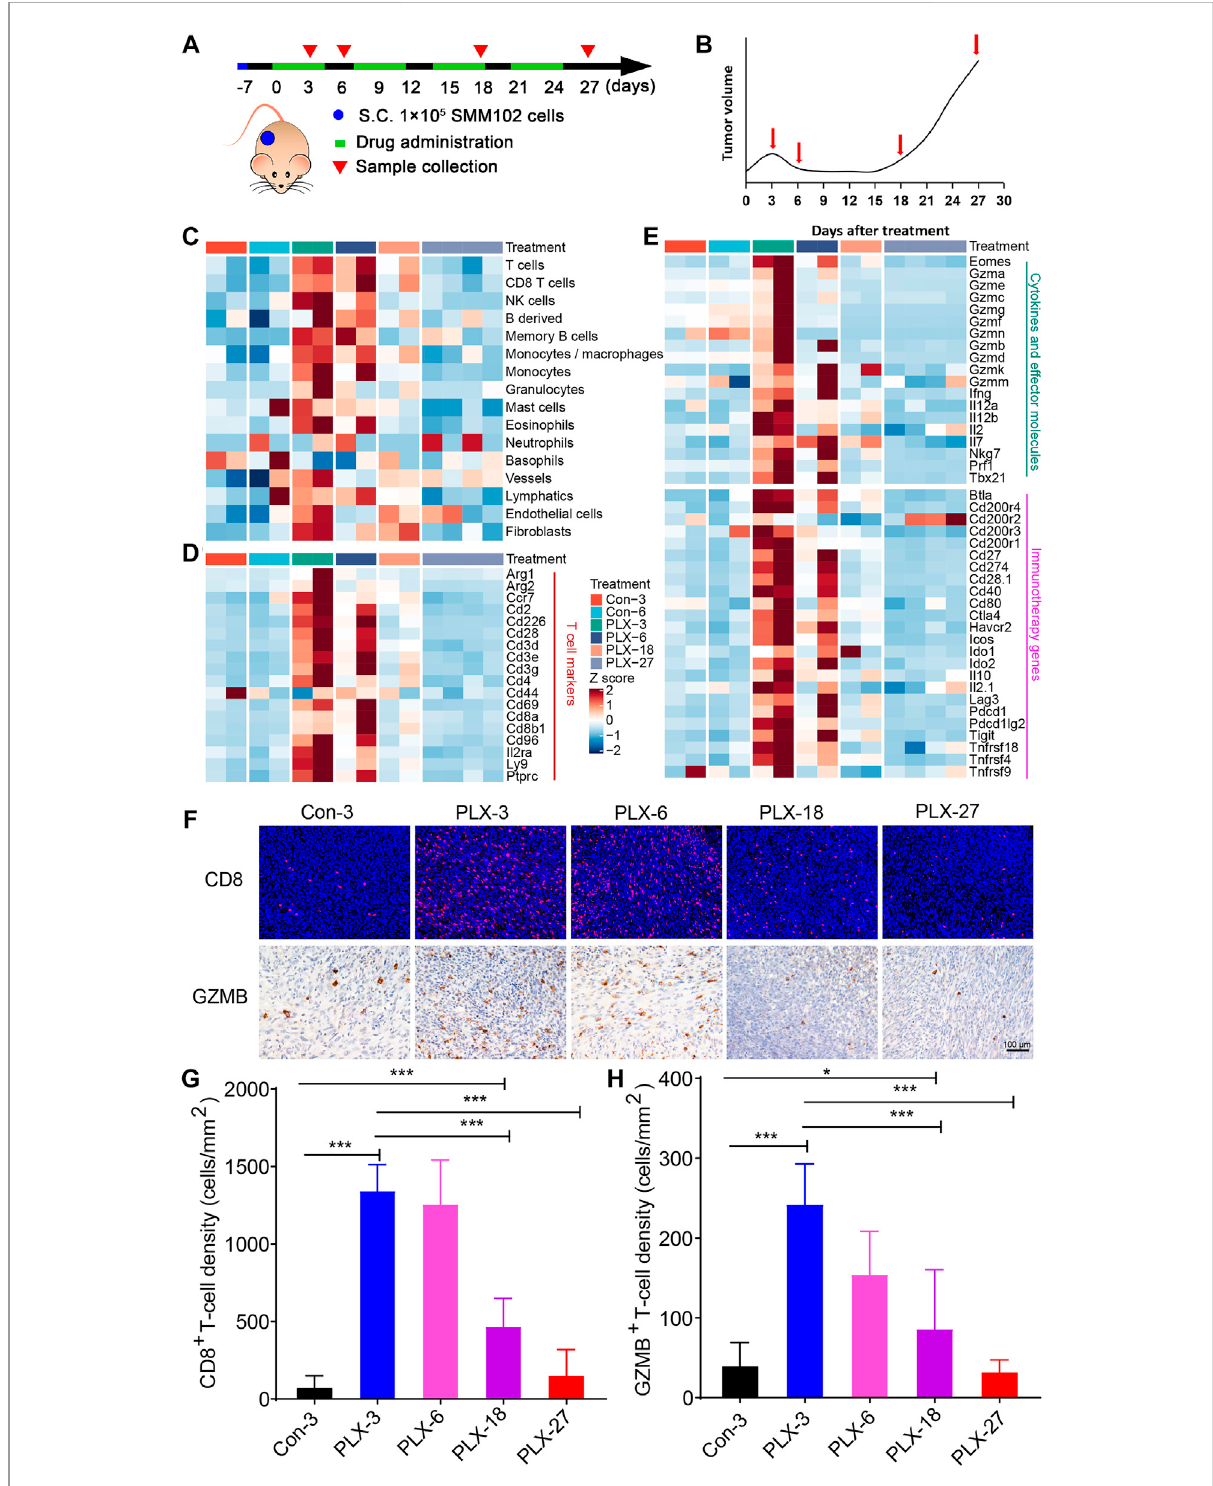
FIGURE 2 Dynamic changes in immune signatures during BRAFi treatment in the mouse melanoma models. (A) Schematic representation of the experimentaldesignusedforthemousemelanomamodelwithorwithoutBRAFitreatment.Onday-7,1×10 ^ 5SMM102tumorcellswereinoculated onthebacksofC57BL/6mice,andthetumor-bearingmiceweretreatedwithsaline(control),orvemurafenib(PLX4032)forthecorrespondingtimes and analyzed at the indicated time points (day 3, 6, 18, and 27). (B) The resistance curve model of SMM102 tumor to vemurafenib. (C) Dynamic